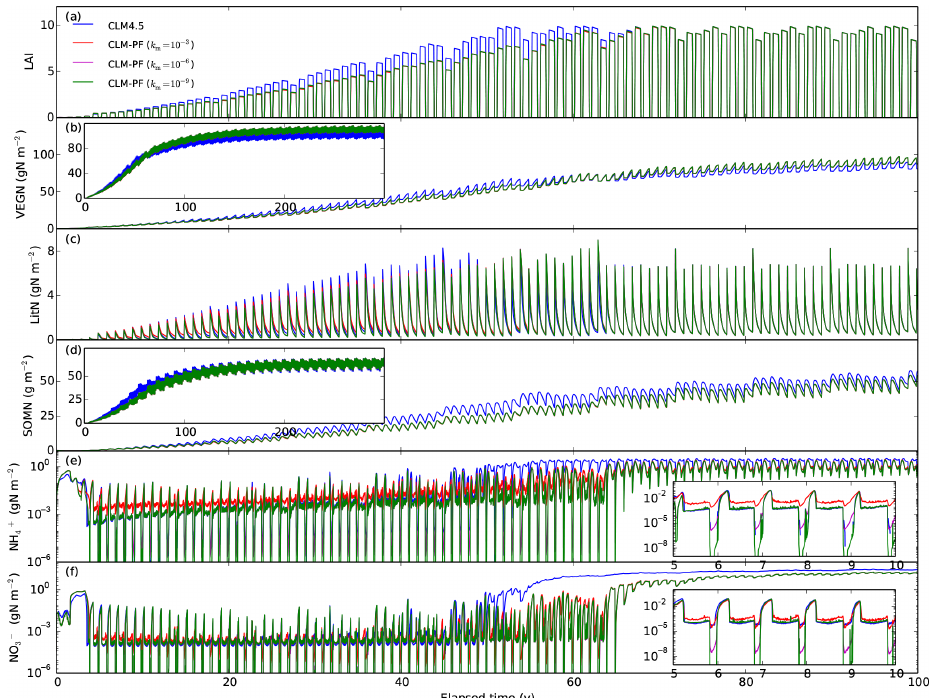
Figure 5. Calculated LAI and nitrogen distribution among vegetation, litter, SOM, NH + WBW